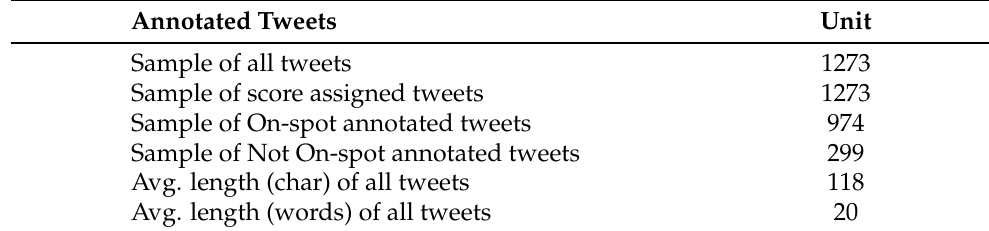
Table 2. A summary of annotated tweets (corpus).